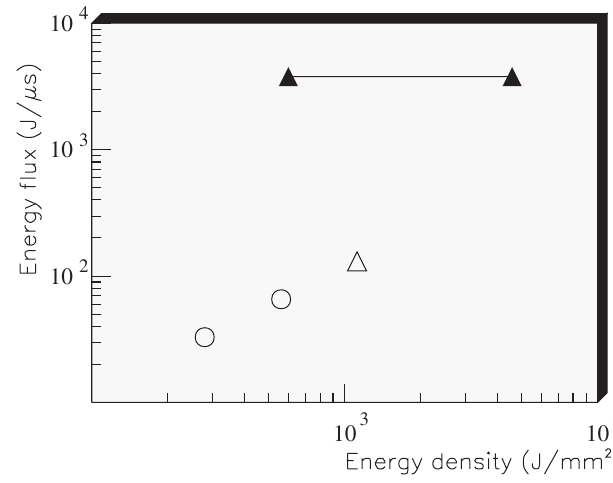
FIG. 10. Results summarized in a plane of the energy density ( J = mm 2 ) and energy flux ( J =(cid:1) s ). The open circle shows results of ILC 0.7 and ILC 1. The open triangle shows that of ILC 2. The line with closed triangles at the ends shows the data range of the KEKB 390